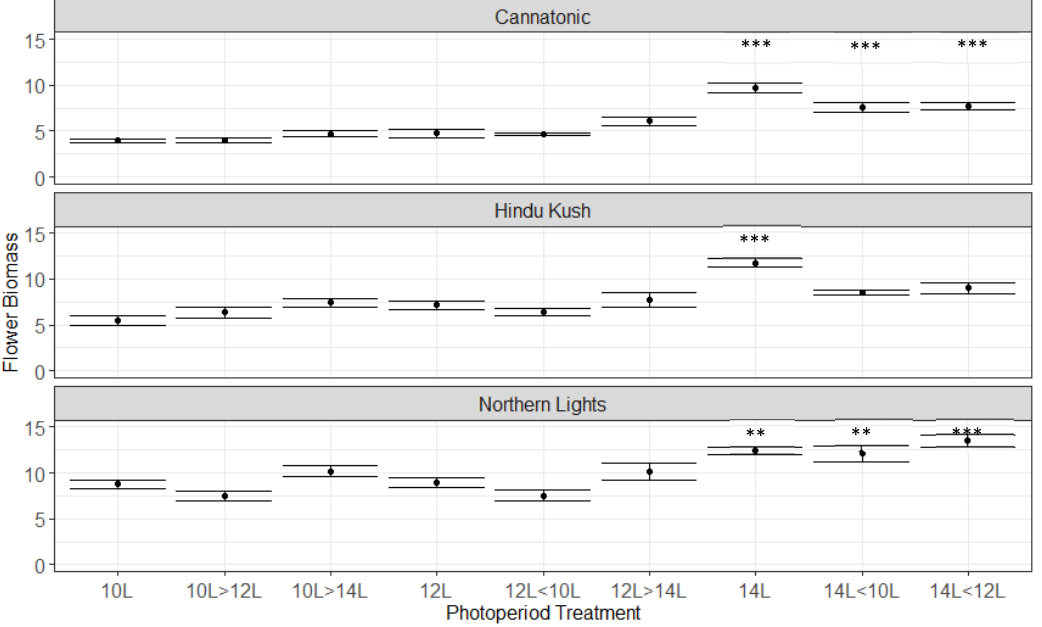
Figure 2. Flower yields (g DW Plant − 1 ) for the 9 treatments. Asterisks above the error bars indicate that the treatment was significantly different to the control 12L treatment, Dunnet’s test, *** p ≤ 0.001, ** p ≤ 0.01, N = 4 − 5 +/ − SE.